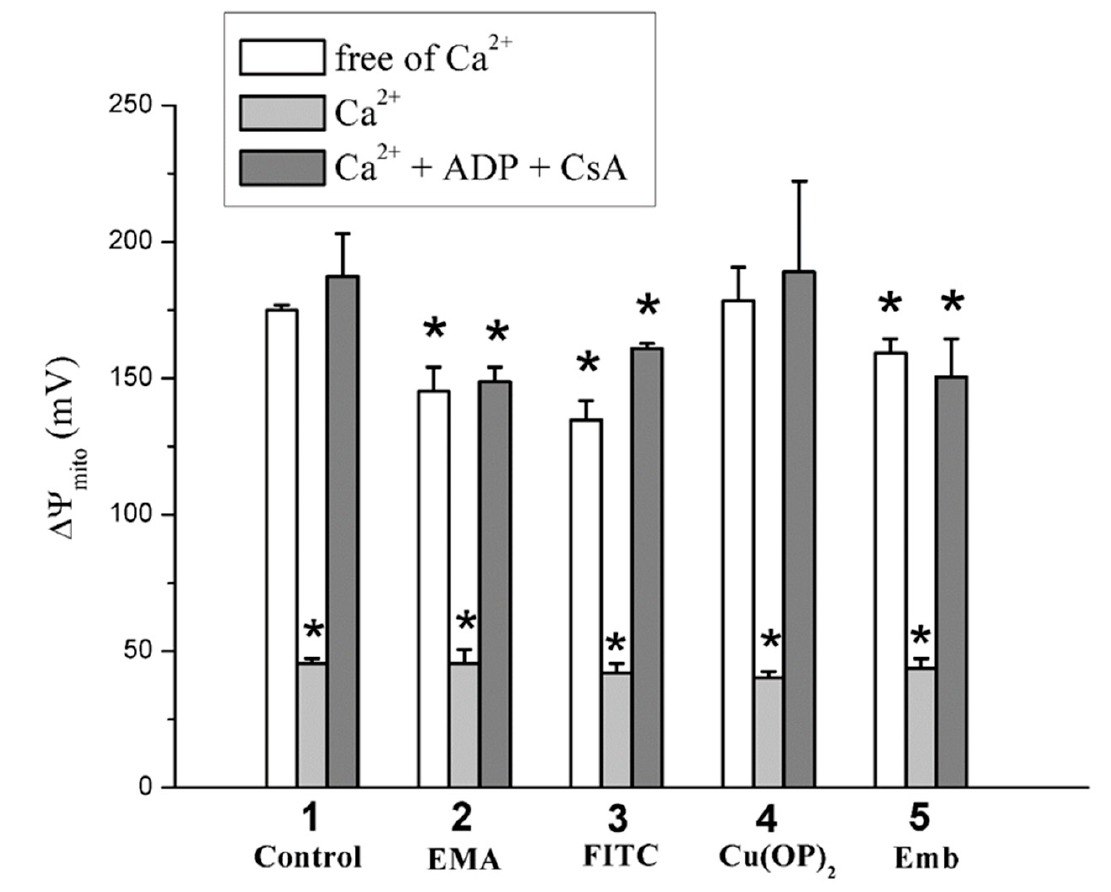
Figure 11. The effect of EMA, FITC, Cu(OP) 2 , Emb, and Ca 2+ on the inner membrane potential ( ∆Ψ mito ). Mitochondria (0.5 mg/mL of protein) were injected into the medium C containing 20 mM TlNO 3 . Ordinate shows ∆Ψ mito change (mV) calculated from safranine O fluorescence intensity (see Section 4). Numerals on the abscissa indicate used reagents: control experiments (1), 50 µ M EMA (2), 100 µ M FITC (3), 3 µ M Cu(OP) 2 (4), and 50 µ M embelin (5), as well as 500 µ M ADP and 1 µ M CsA (where indicated) were correspondingly added into the medium C before mitochondria and Ca 2+ . Next, 75 µ M Ca 2+ was injected into the medium after mitochondria. Asterisks show significant differences from the control experiments free of Ca 2+ and thiol-modifying agents ( p <